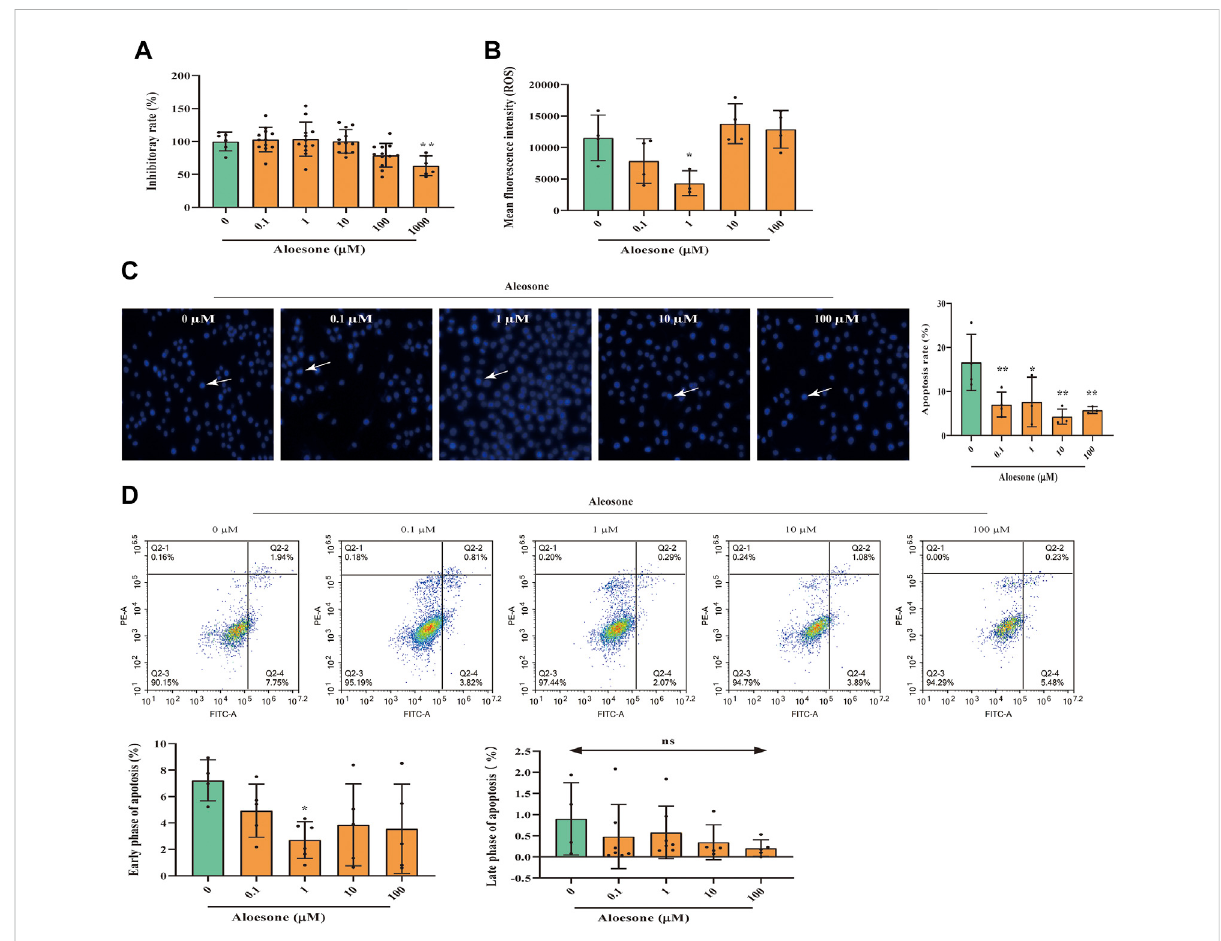
FIGURE 2 Effects of aloesone on glutamate-induced HT22 injury. (A) Inhibitory effect of aloesone (0.1 – 1,000 µM) on HT22 cells. (B) ROS content in HT22cells treatedwith glutamate alone oracombinationofglutamate andaloesone. (C) Representative images andanalysishistograms ofHoechst staining. Cells with condensed chromatin and nuclear shrinkage underwent apoptosis. Apoptosis rate was calculated using the following formula: numberofapoptosiscells/totalcell. (D) Representativephotographsforannexin Ⅴ -FITCandPIanalyse.* p < 0.05comparedwiththeglutamate